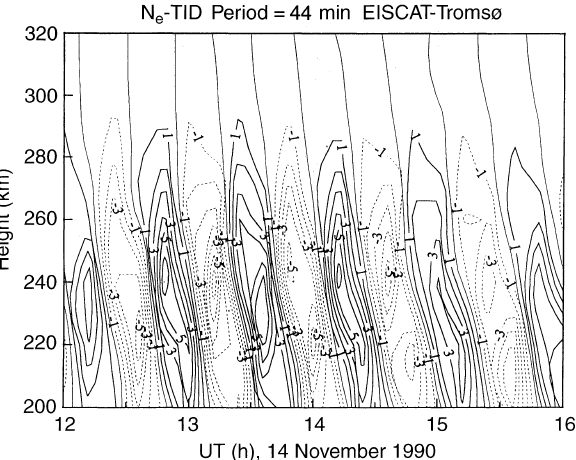
Fig. 7. Contours of electron density fractional fluctuations within a period band of 40–50min versus time and height for 14 November 1990 (position A)